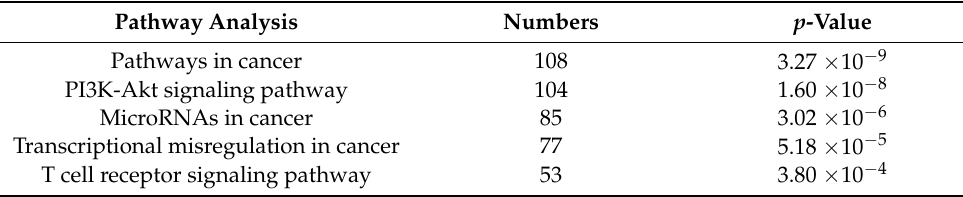
Table 3. The pathway enrichment analysis by applying The Database for Annotation, Visualization and Integrated Discovery (DAVID) in core GWGEN of non-triple-negative breast